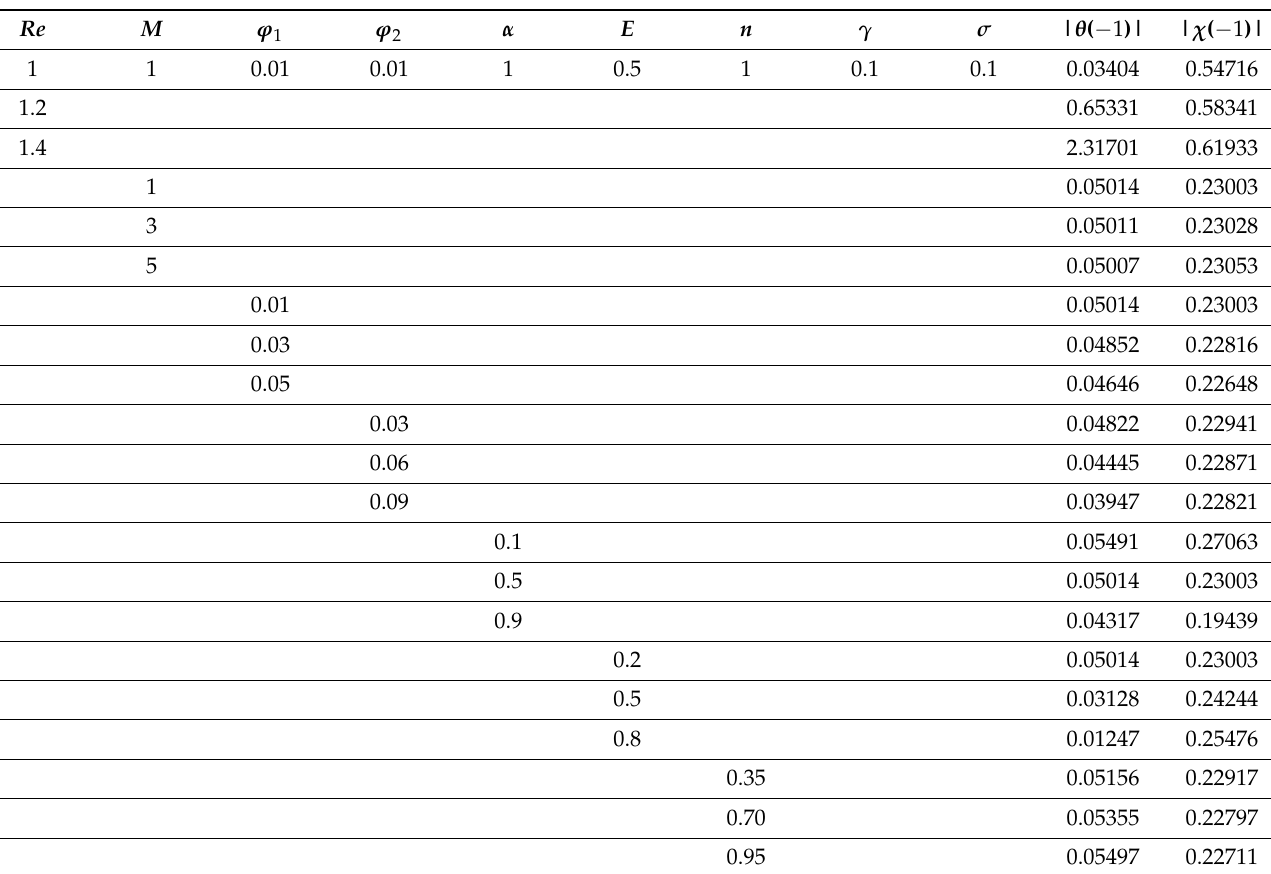
Table 4. Impact of flow heat and mass transfer for different nondimensional parameter values such as the Reynolds number, magnetic parameter, volume of fraction, expansion ratio, and E , n , γ , σ